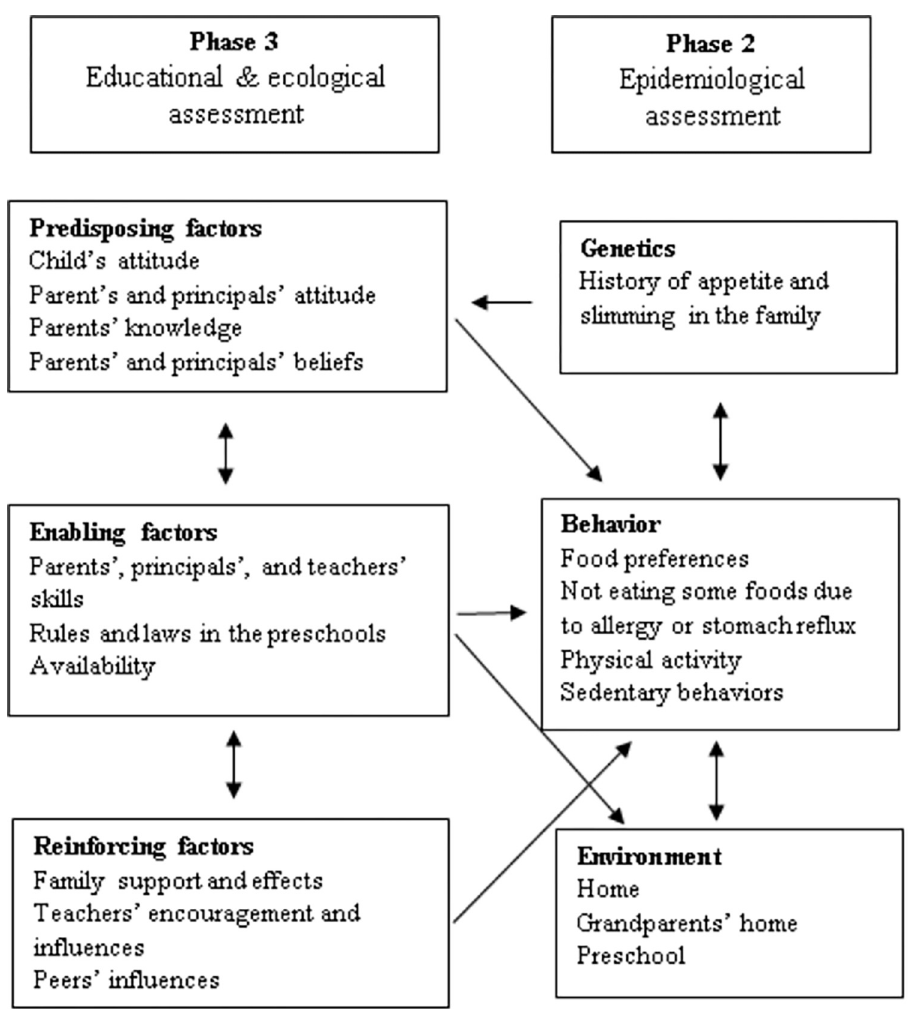
Fig 1. PRECEDE-PROCEED model to understand perceptions and experiences of Iranian parents and principals of preschool children on weight